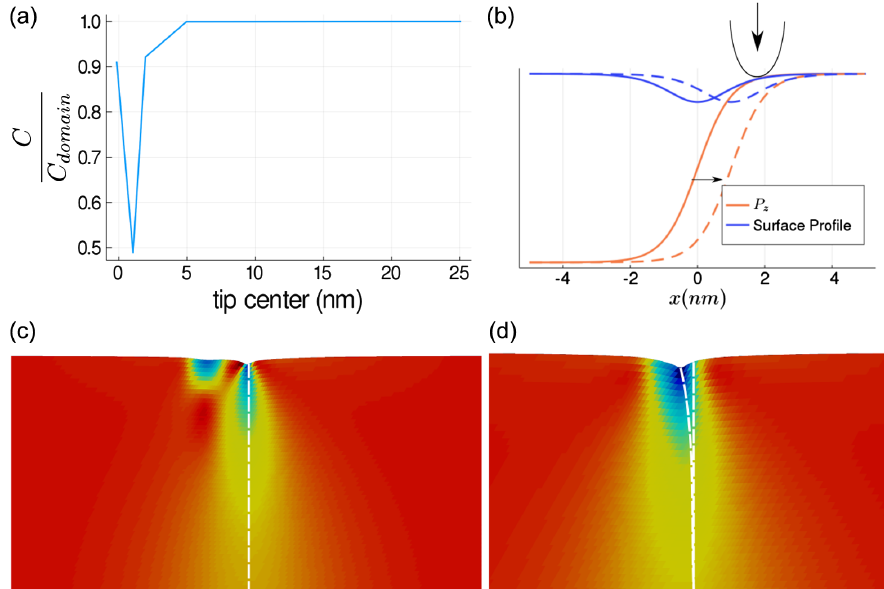
FIG. 4. (a) Simulated change of stiffness as a function of the distance between the CRFM tip and a domain wall. The softening is maximized slightly away from the domain wall, but within its strain footprint, where the DW sliding mode contribution is important. The experimental situation corresponds to averaging within the tip region. (b) Schematic representation of the sliding mode. The polarization and strain profiles are shifted by dx . (c),(d) Simulated strain profiles shown on a slice of the sample when the tip is near the DW (c) or further away (d). The dashed vertical line shows the initial position of the ferroelectric DW. The wall slides toward the tip in (c), as shown by the curved dashed line, whereas it does not move in